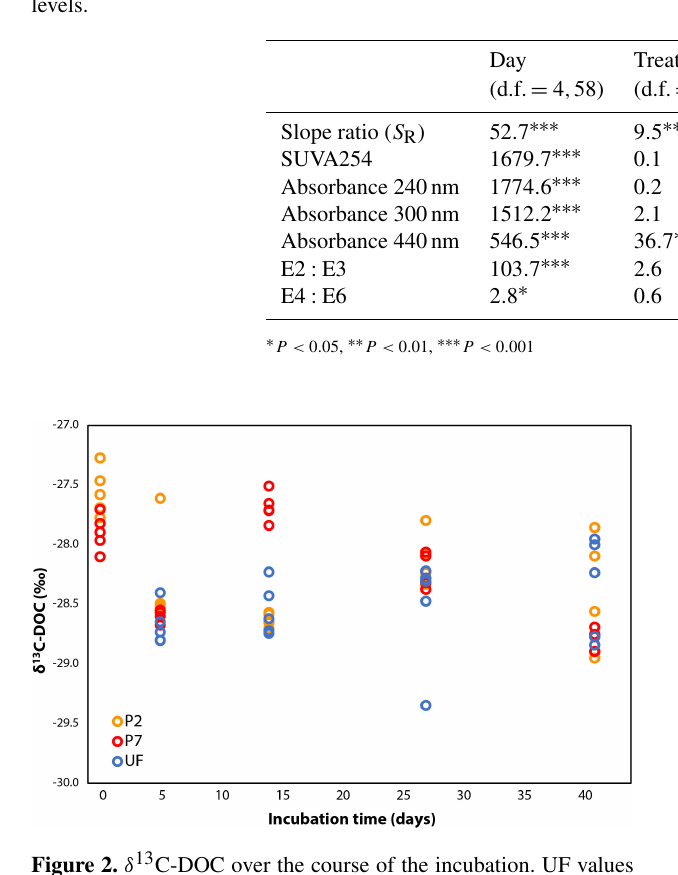
Figure 2. δ 13 C-DOC over the course of the incubation. UF values are the same as P7 for day 0 because the DOC subsamples were treated in the same manner, so a further set of technical replicates was deemed unnecessary (see Sect.